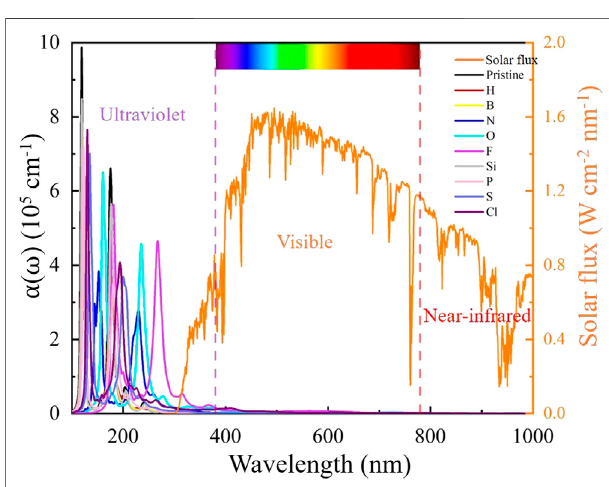
FIGURE 6 | The absorption spectrum of intrinsic SiC and NM-SiC systems.